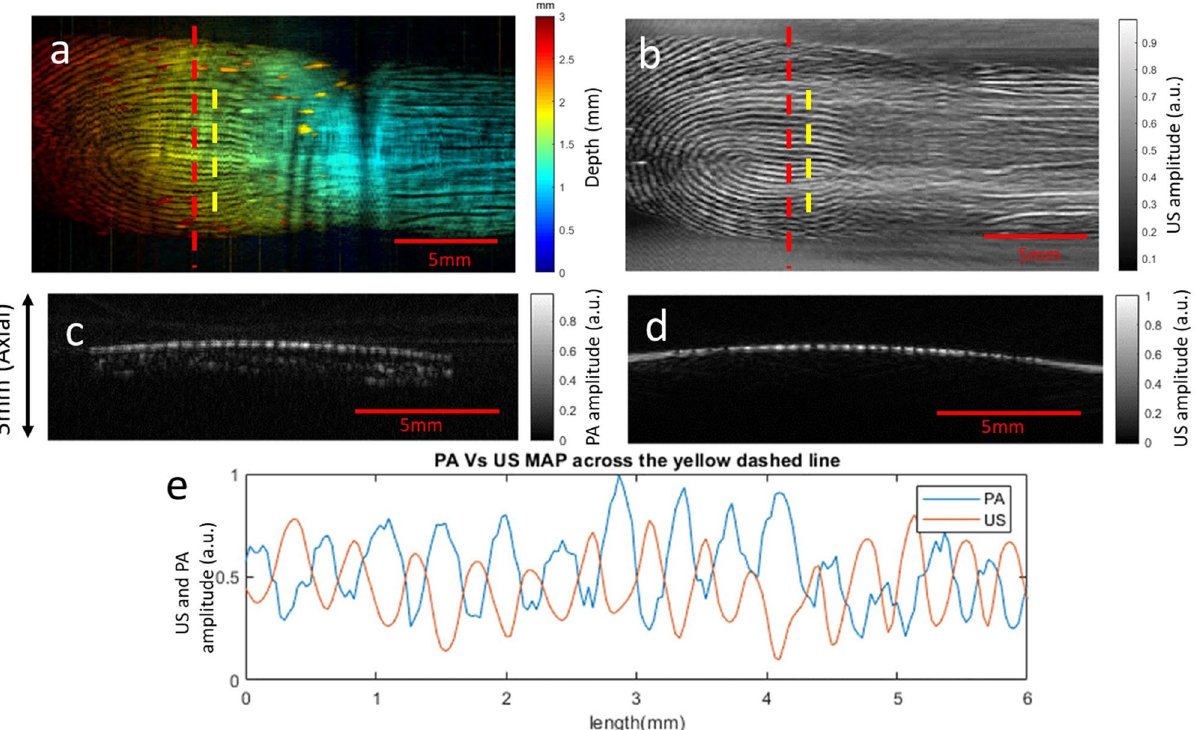
Figure 6. Photoacoustic and ultrasound images of a dry finger. ( a ) Depth-encoded photoacoustic image. ( b ) Gray-scale ultrasound image. ( c ) Cross-sectional PAT image across the red dashed line in ( a ). ( d ) Cross- sectional US image across the red dashed line in ( c ). ( e ) Intensity profiles of the ultrasound and photoacoustic images across the yellow dashed lines in both ( a ) and ( b